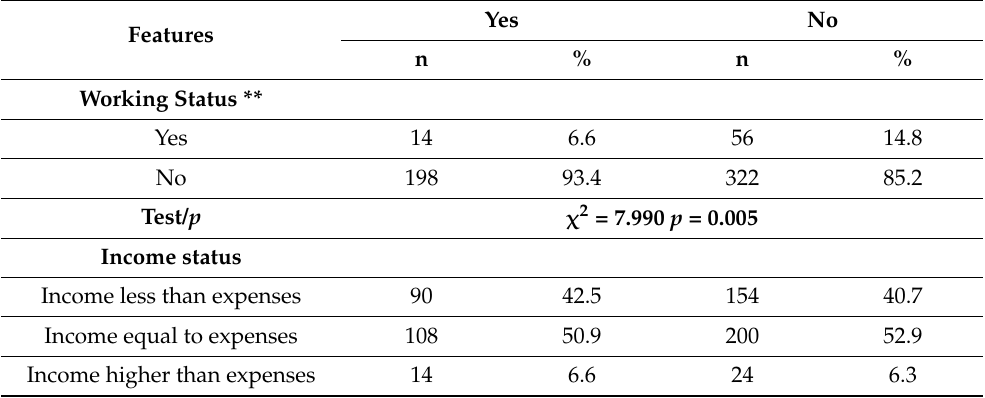
Table 3. Distribution of some characteristics of students according to post-vaccine health